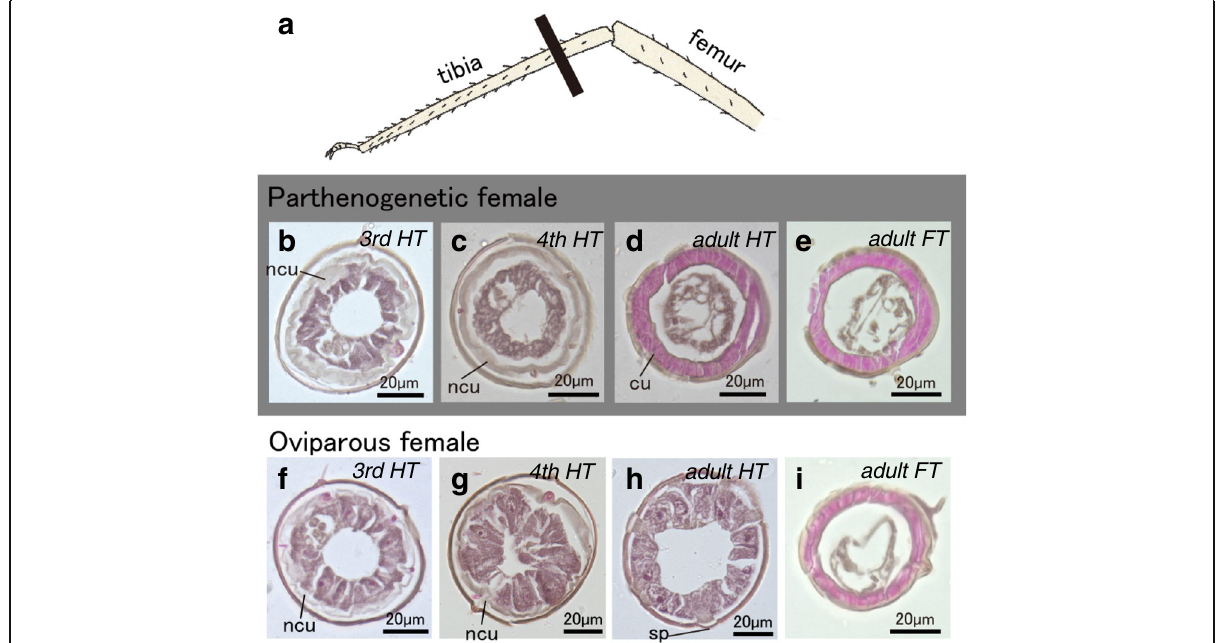
Fig. 3 Inner structures of tibias in parthenogenetic and oviparous females. a : Diagram showing the histologically observed plane, which is indicated by a black bar. b – d : hind tibias (HT) of parthenogenetic females [third, fourth, and fifth (adult) instars]. e : Foreleg tibia (FT) in an adult parthenogenetic female. f – h : HT of oviparous females (third, fourth, and fifth instars). i : FT of an adult oviparous female. cu: cuticle, ncu: newly synthesized cuticle, sp.: scent